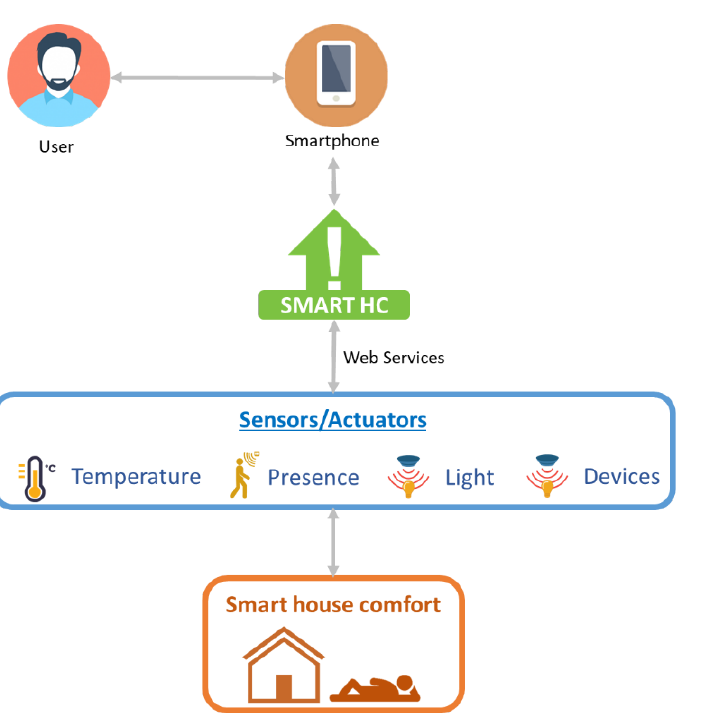
Figure 6. Visual representation of the scenario.